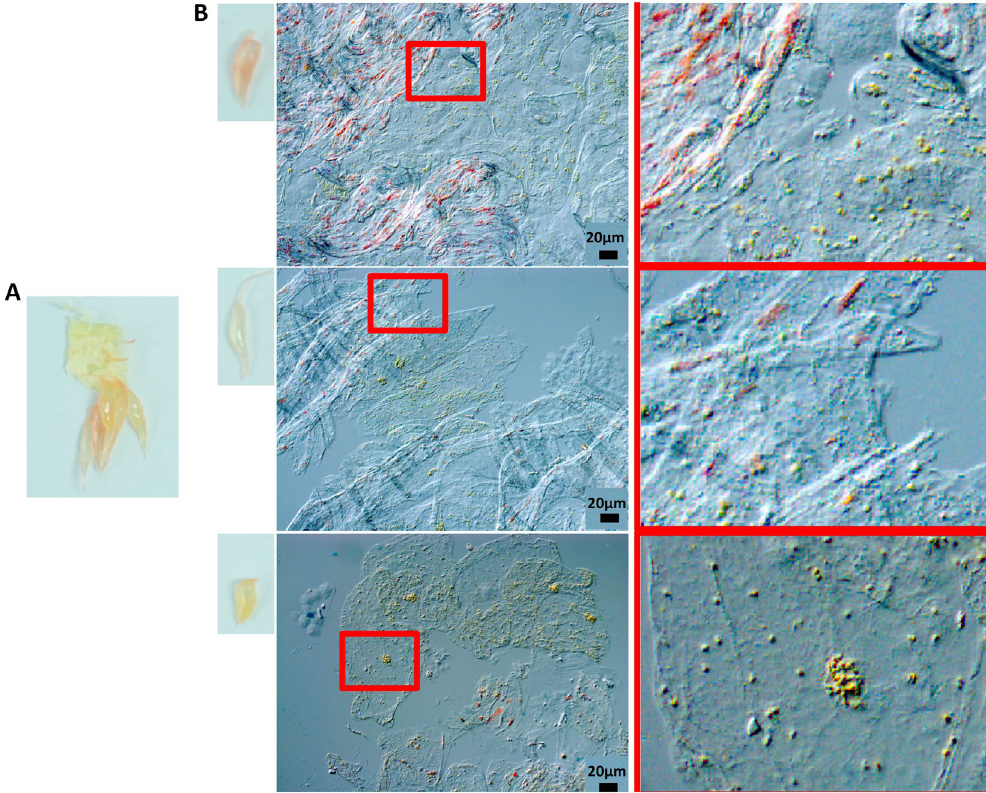
Figure 4. Microscopic observation of cells from different colored juice vesicles of Cara Cara ripe fruit. ( A ) Photograph of dissected Cara Cara fruit with different colored juice vesicles located close to each other. ( B ) Cells from red to yellow juice vesicles under DIC (differential interference contrast) microscope.